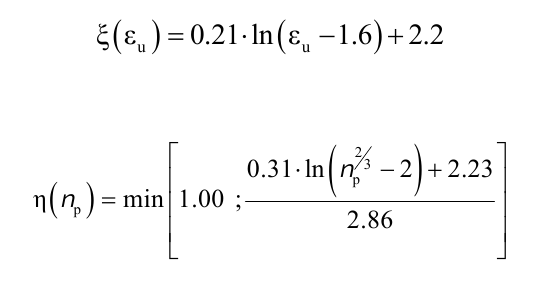
Figure 2. The β correction factor of the effective width as a function of ε